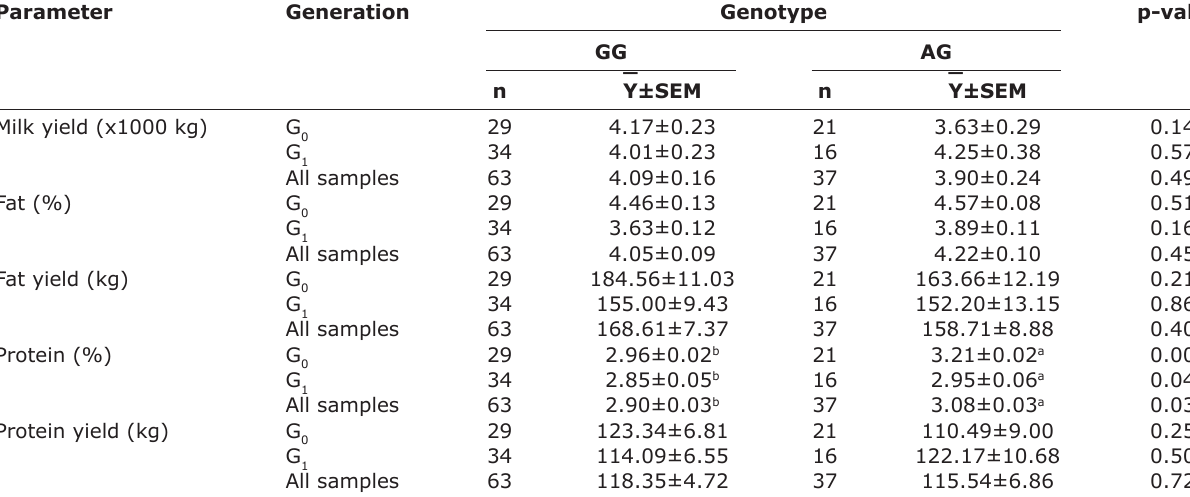
Table-3: Association of FASN rs41919985 with milk traits. Parameter Generation